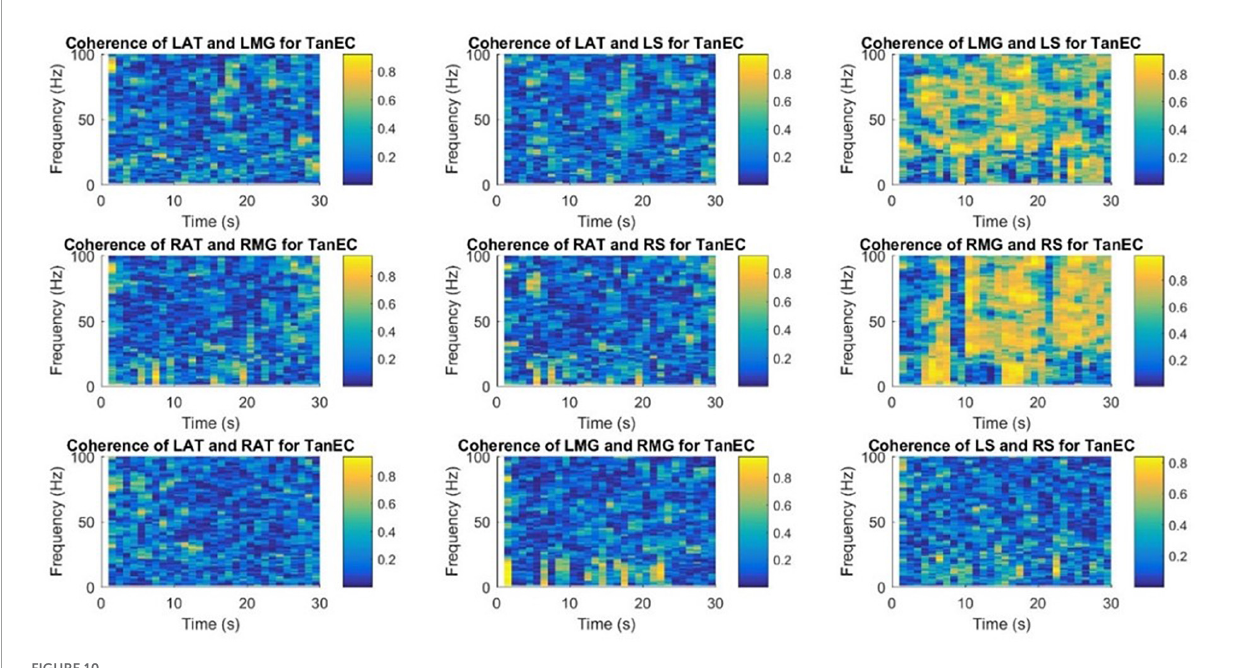
FIGURE10 Time-frequency coherence spectrogram of different muscle pairs under TanEC condition for a single participant for a single trial. The figure represents EMG-EMG coherence of different muscle pairs for a particular frequency and time with blue representing the lowest intermuscular coherence and yellow representing higher coherence between muscle pairs under the least stable postural standing position. Note that at all frequencies, the coherence is higher between RMG and RS for TanEC